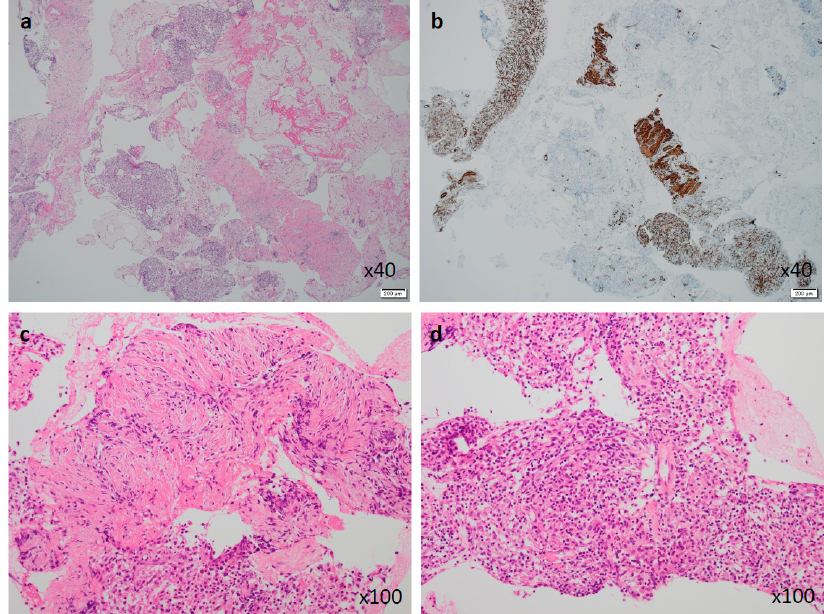
Figure 4. Tissues obtained by EUS-guided fine needle aspiration biopsy (EUS-FNAB). Low-power view of hematoxylin-eosin (HE) staining showed mixed components of dense myofibroblastic tissues and aggregated inflammatory cells (×40). ( a ) Anti-smooth muscle actin was diffusely positive in the myofibroblastic components (×40). ( b ) High-power views showed a myofibroblastic cell component ( c ) and an inflammatory cell component ( d ) without malignant cells (HE, ×100). Diagnostics 2019 , 9 , x FOR PEER REVIEW